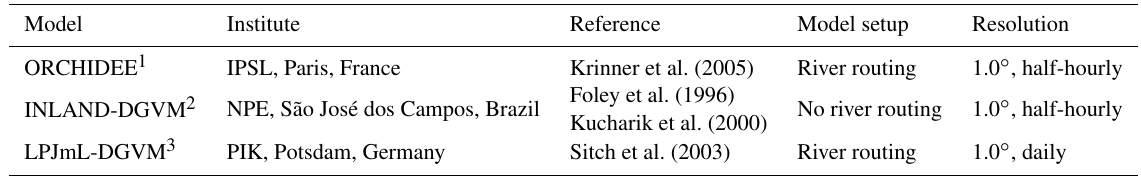
Table 1. Models used in this study.